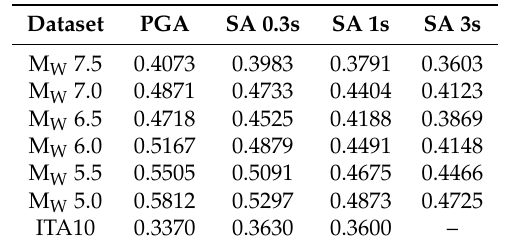
Table 2. Standard deviations of GSs synthetic dataset compared to that of the reference GMPEs for Italy (ITA10, [41]).